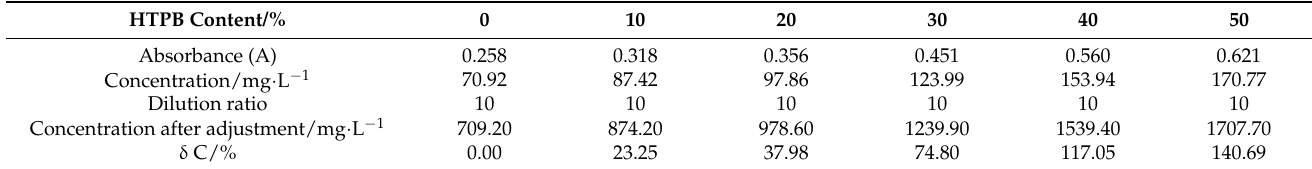
Table 7. Concentration of residual dye after the first reduction cleaning.